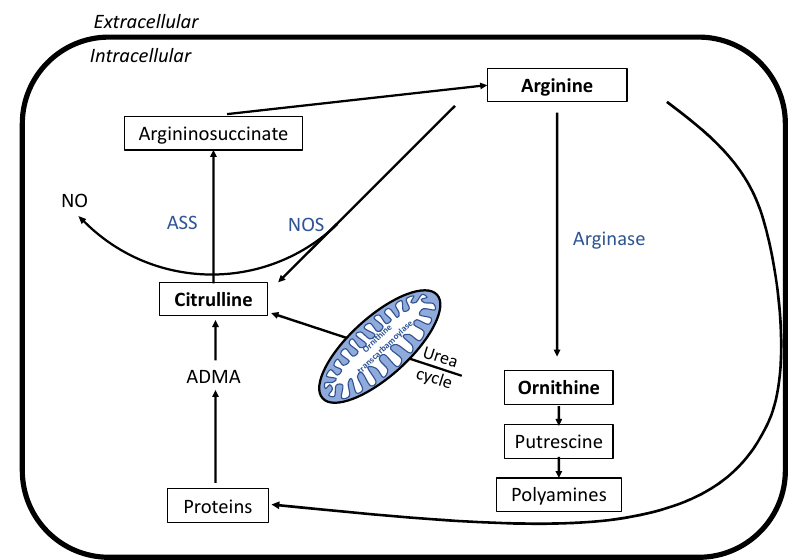
Figure 5. Relevant metabolic pathways involved in exercise-induced changes of arginine metabolism. Black fonts represent metabolites, blue font enzymes. ASS: argininosuccinate synthase, NOS: nitric oxide synthase, NO: nitric oxide, ADMA: asymmetric dimethylarginine.